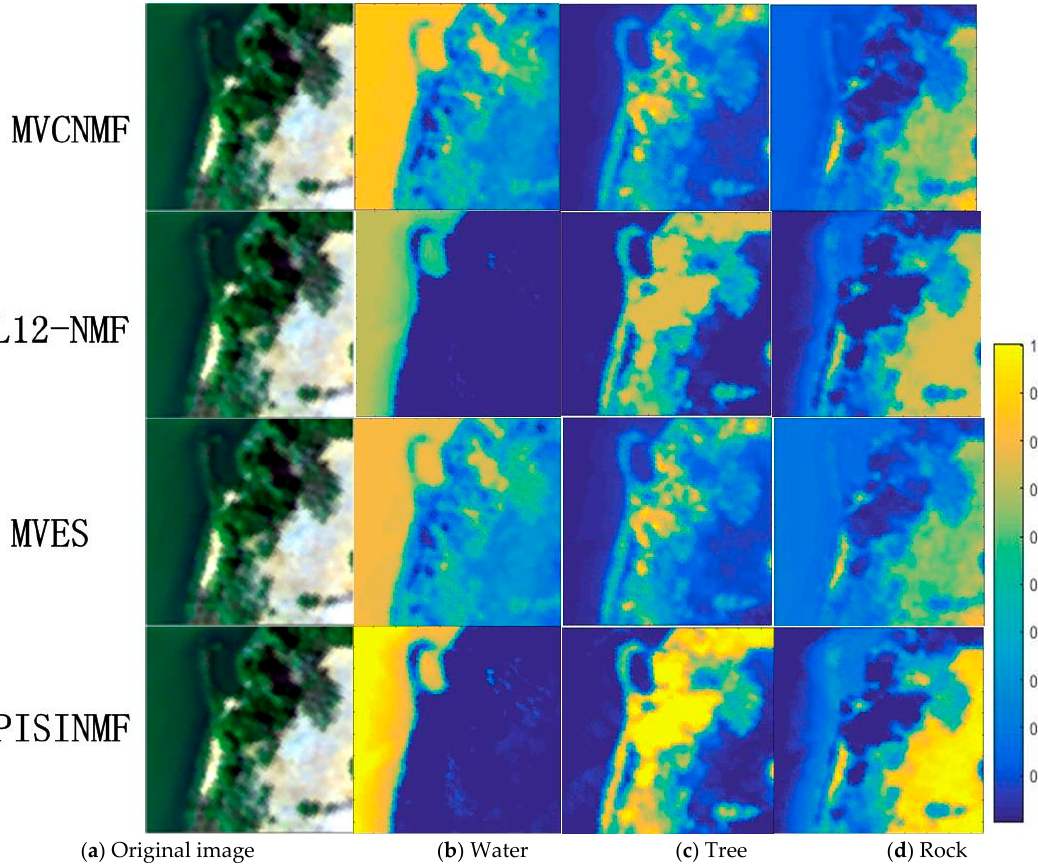
Figure 13. Subimage of Samson hyperspectral dataset. Table 9. SAD results on the Samson data.